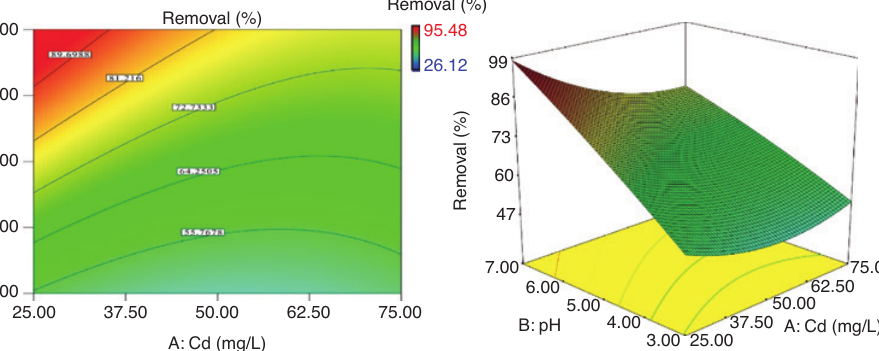
Figure 4: The contour and three-dimensional diagrams of Cd removal efficiency (%) as a function of initial Cd concentration and pH.